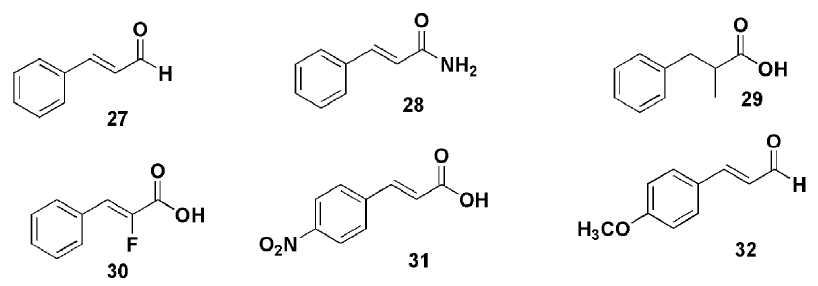
Figure 5. Chemical structures of compounds, 27 – 32 [16].